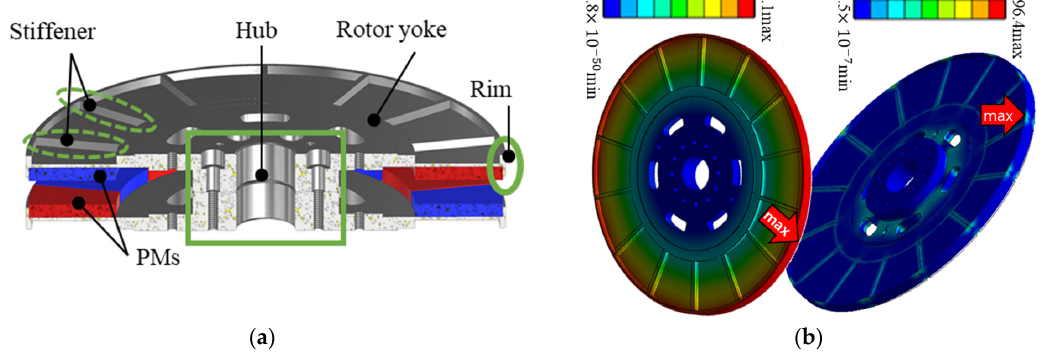
Figure 8. ( a ) Structure of the rotor; and ( b ) stress analysis result for the rotor frame.